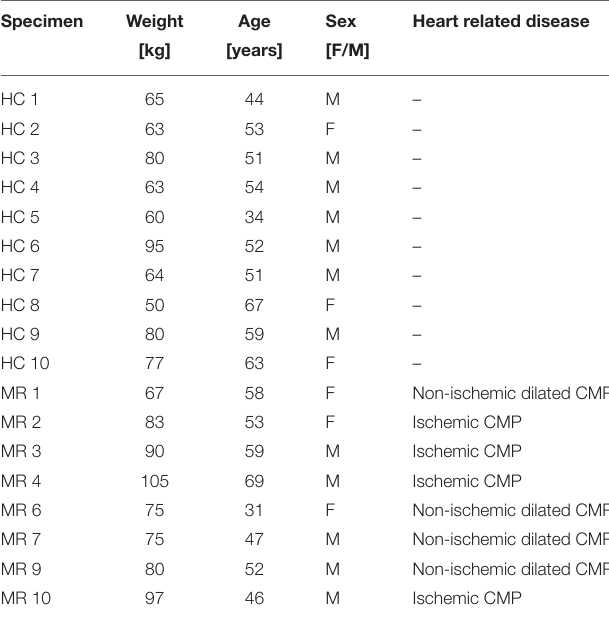
TABLE 1 | Details of the mitral valve donors, including weight, age, sex (female/male), and heart related disease.